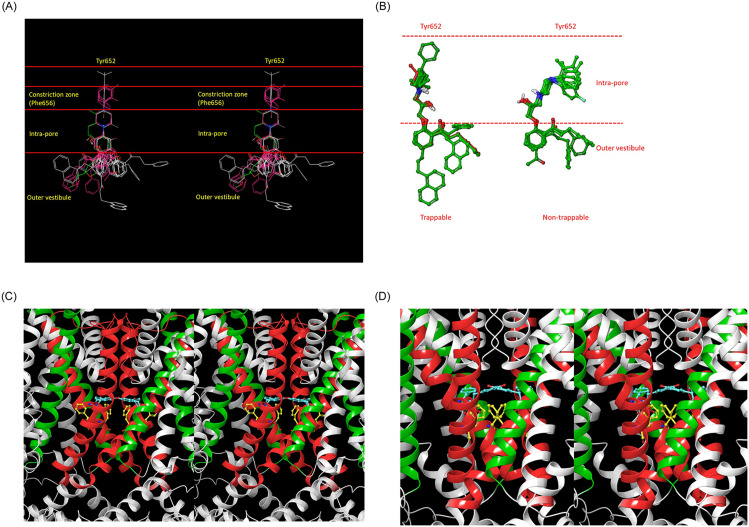
Our blocker overlay model (Fig 3) mapped to the various zones of the channel, including the putative trappability-determining constriction zone that forms during channel closing, from which non-trappable blocker moieties are sterically excluded.(A) Stereo view of the blocker overlay. All of the trappable propafenone analogs either terminate prior to this zone, or project a planar group into it (magenta) that coincides with the pore axis. (B) Zoomed-in view of the putative blocker constriction zone, demonstrating the non-planar conformations of non-trappable blockers in this region. (C) The open constriction zone, comprised of Phe656 (yellow side chains) in hERG, with Tyr652 shown for reference (cyan side chains). (D) The closed constriction zone, comprised of Phe468 (yellow side chains), with Tyr464 shown for reference in EAG1 (cyan side chains).